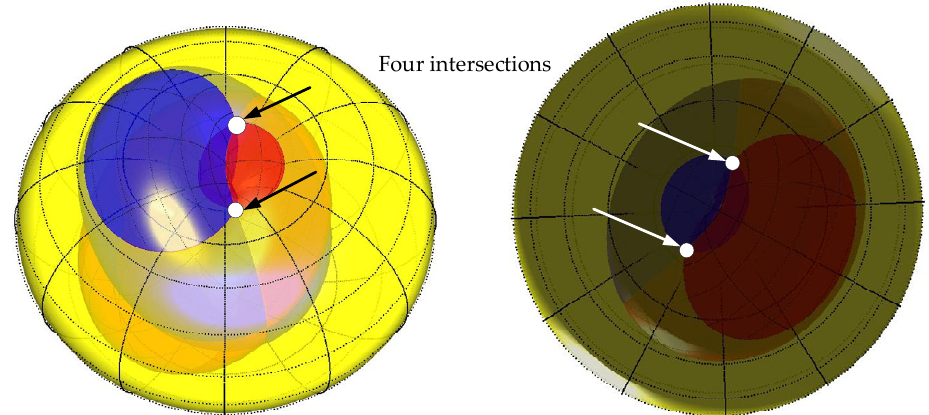
Figure 6. Four intersections from three surfaces.